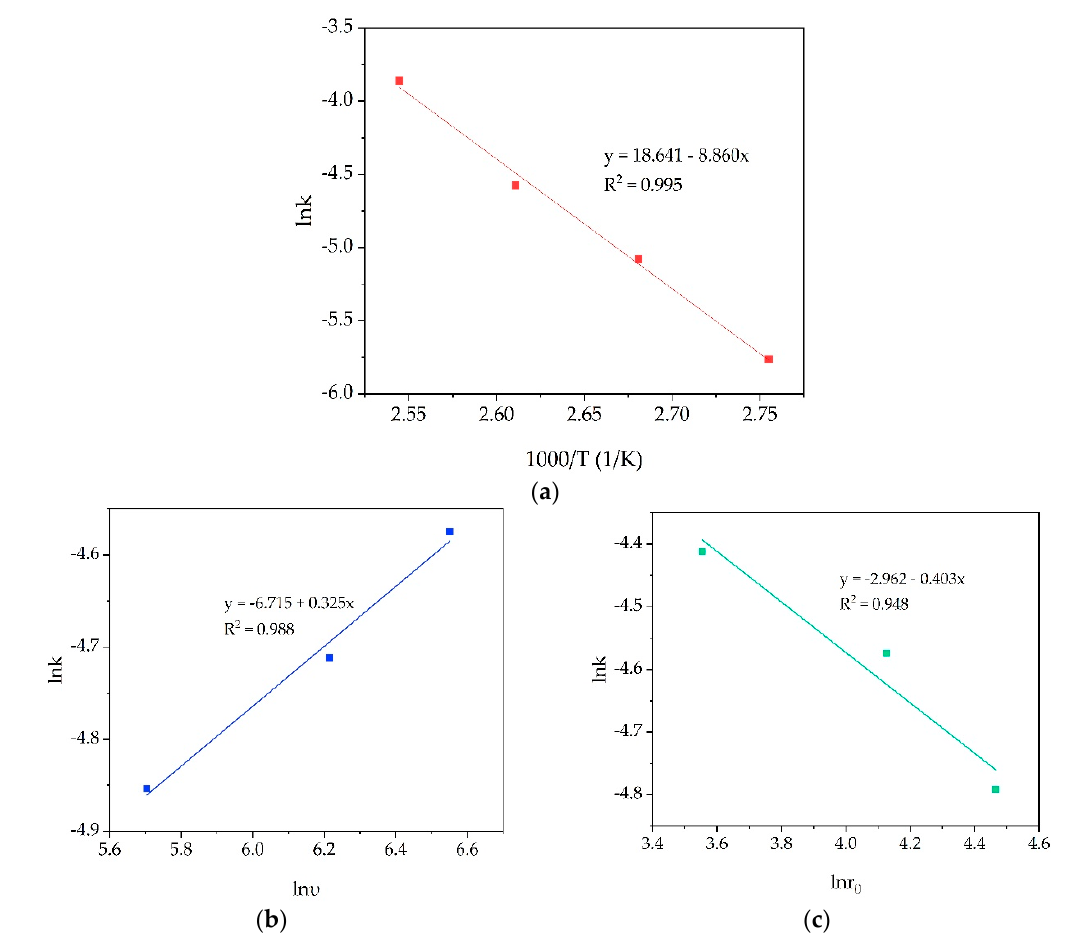
Figure 6. Relationship between lnk–1000/T from Figure 5a ( a ); lnk-ln υ from Figure 5c ( b ); and lnk-lnr o from Figure 5d ( c ) for CFA desilication by NaOH at L/S ratio = 20:1.